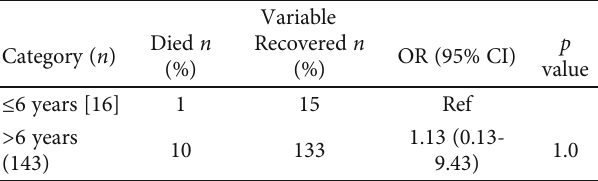
Table 3: Association between age less than 6 and risk of